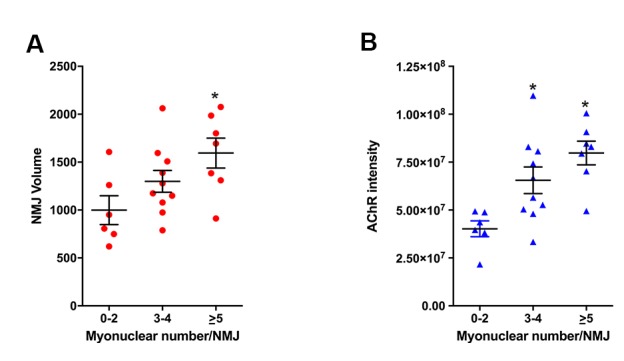
NMJ size, based on post-synaptic apparatus volume and AChR intensity, positively correlates with the size of post-synaptic myonuclear clusters.(A) NMJ volume and (B) AChR cumulative intensity positively associates with number of post-synaptic myonuclei. *p<0.05 compared to 0–2 group, one-way ANOVA/Tukey multiple comparison test. n = 23 NMJs.